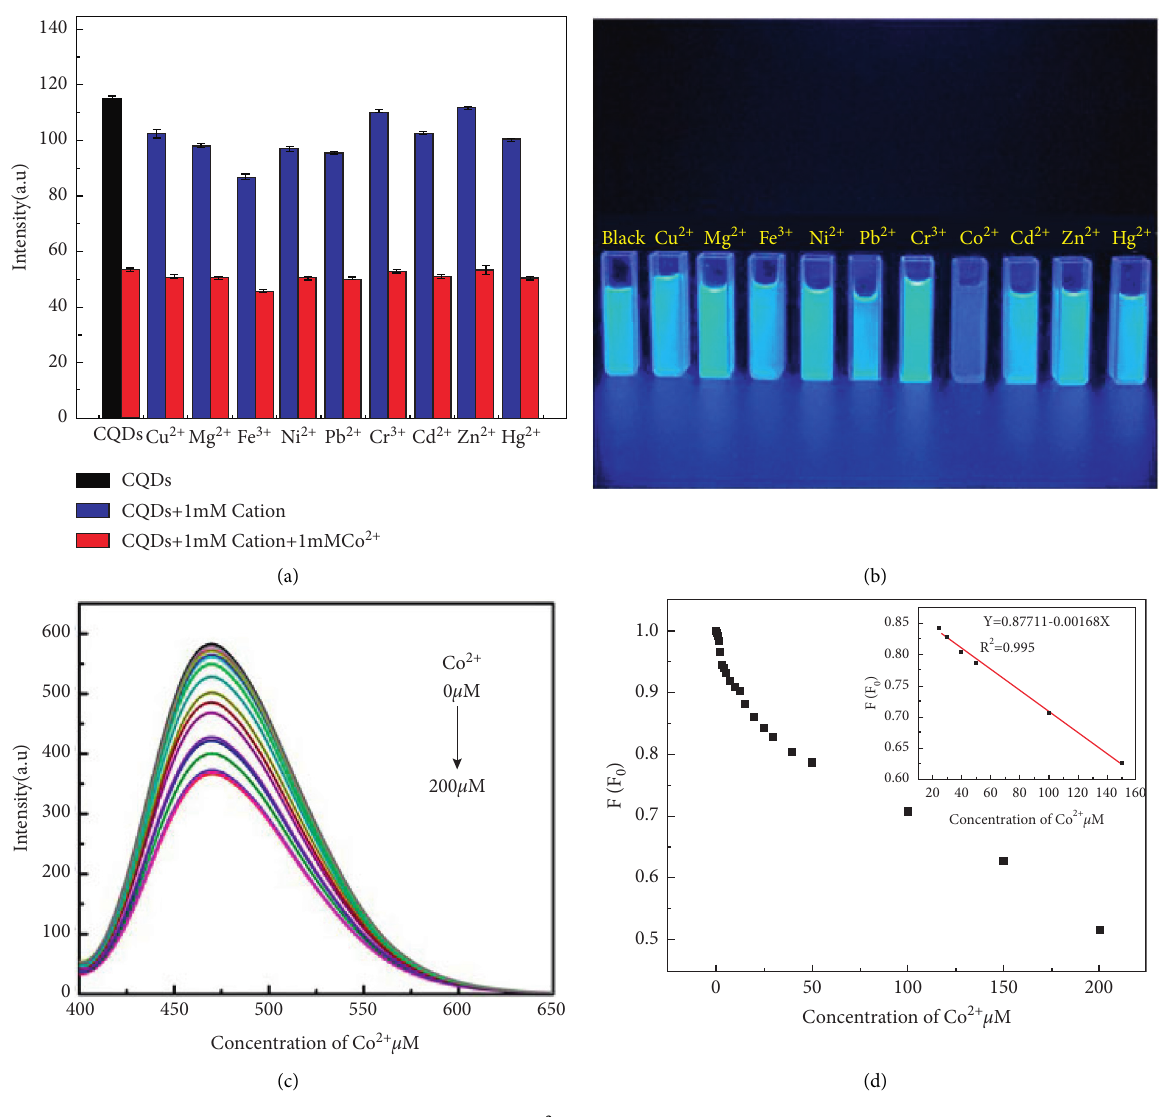
Figure 8: (a) The selectivity test of CQDs (0.8mg/mL) for Co 2+ against different metal ions (excitation wavelength � 390nm); (b) FL photographs of CQDs with various metal ions under the UV-lamp ( λ � 365nm); (c) FL emission spectra of the CQDs (0.8mg/mL) upon exposure to various concentrations of Co 2+ (from top to bottom: 0, 1, 2, 3, 4, 6, 8, 10, 15, 20, 25, 30, 40, 50, 60, 80, 100, 200 µ M) in aqueous solution excitation at 390nm; (d) The calibration curves and linear equation for the FL quenching ratio and concentration of Co 2+